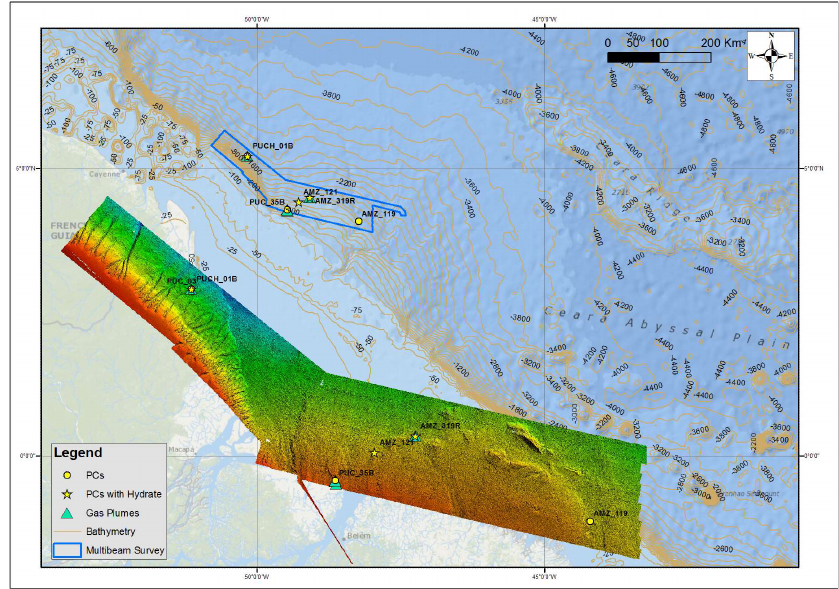
Figure 1. Location map showing the bathymetry (coloured) of the study area in the Amazon deep-sea fan, the adjacent continental slope area to the northwest with small canyons connected to a main canyon channel. The blue dots are the piston cores used in this